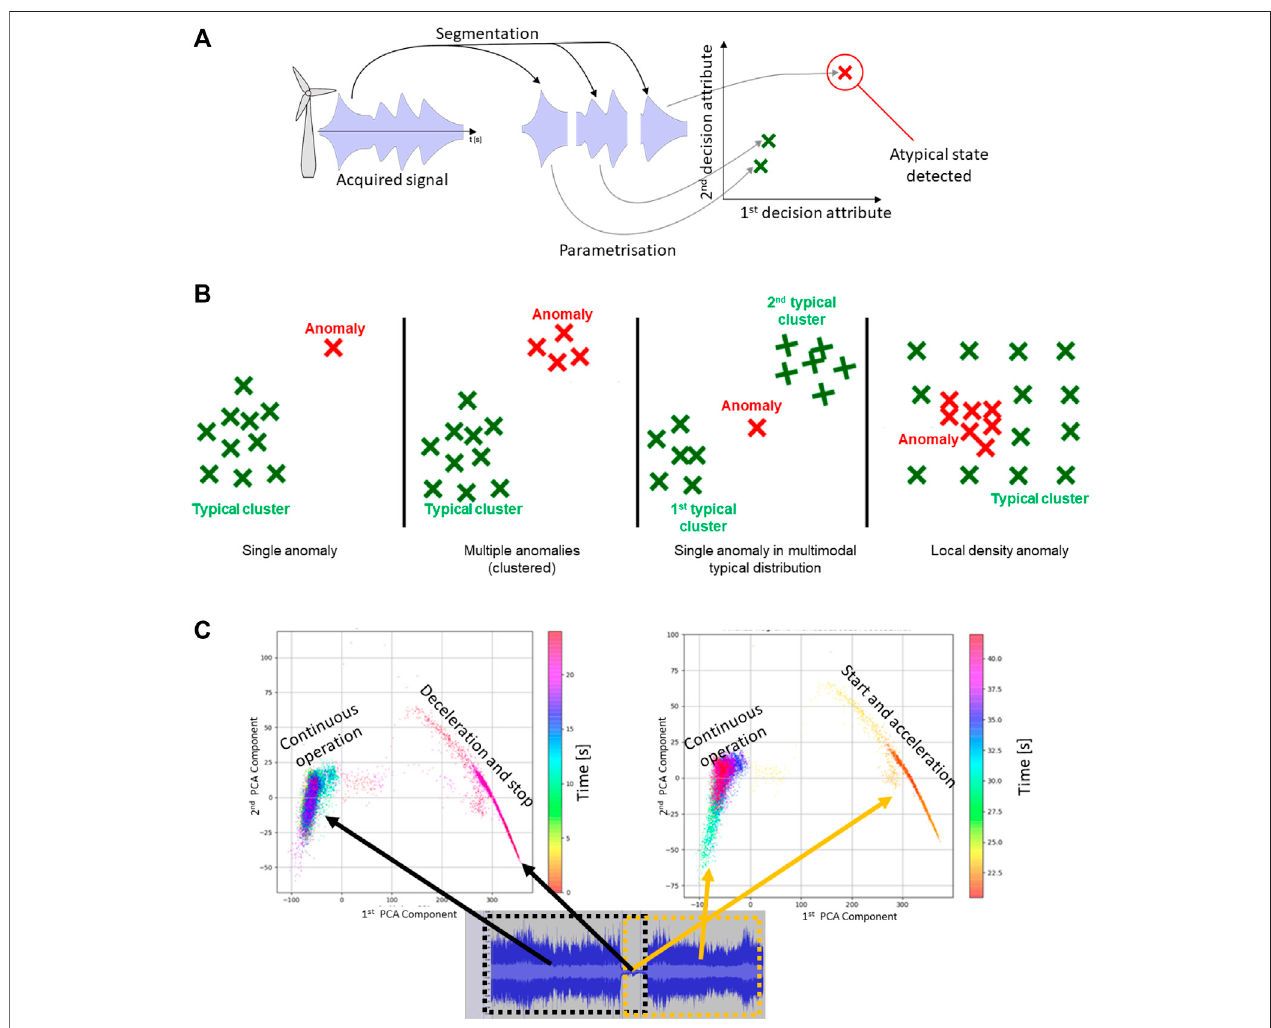
FIGURE 10| Concept of signal processing for deviation detection (A) , examples ofpossible deviations from the standard (B) , visualization of parameters obtained from the acoustic signal of the turbine (C) .